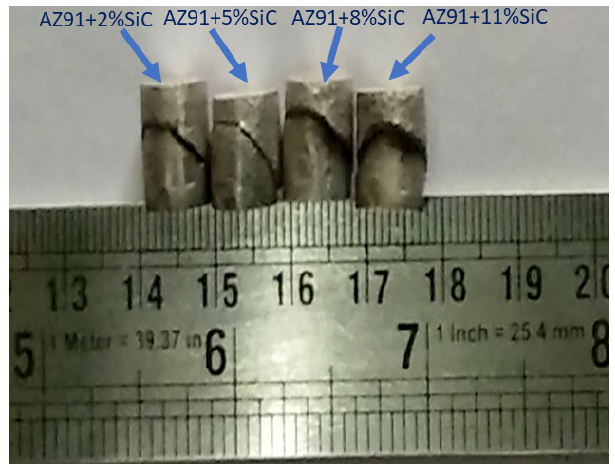
Figure 10. Fractured samples in a compression test.